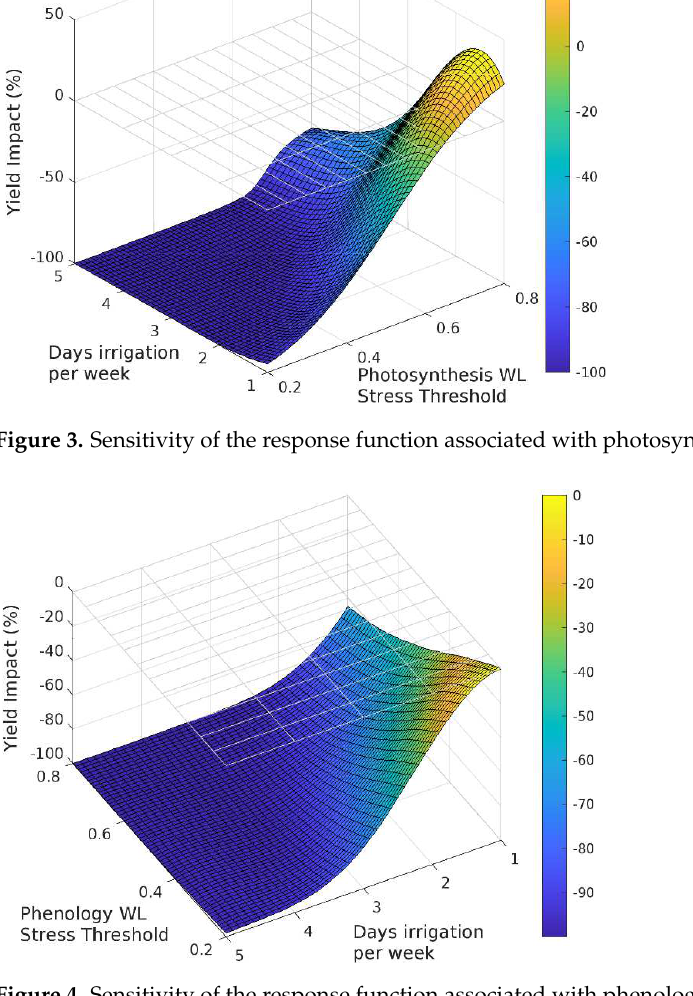
Figure 5. Sensitivity of yield to waterlogging associated with leaf expansion on grain yield.